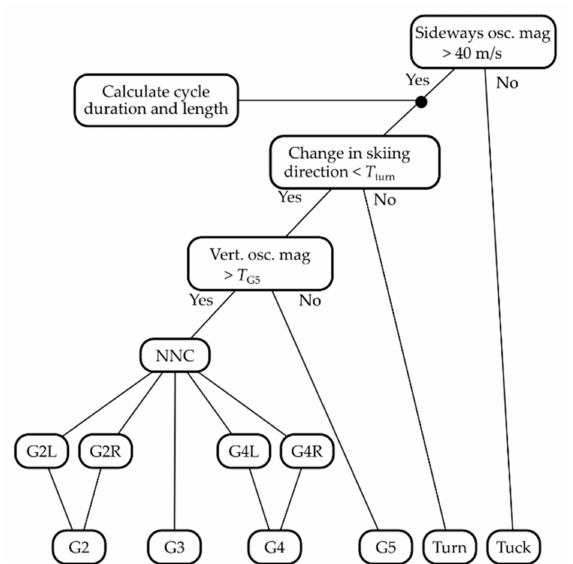
Figure 5. Classification tree for the field validation experiments. A Short-time Fourier transform STFT was used to check for oscillatory movement of the head and rate of turning prior to submitting the measurements to the NNC. Measurements were only passed to the NNC if oscillatory movement magnitude in both sideways and vertical directions was above given thresholds, and if the change in skiing direction was less than a threshold. The NNC classified the left/right symmetric variants of G2 and G4 individually, but these were merged to single classes for the validation, resulting in 6 sub-technique categories: G2, G3, G4, G5, Turn and